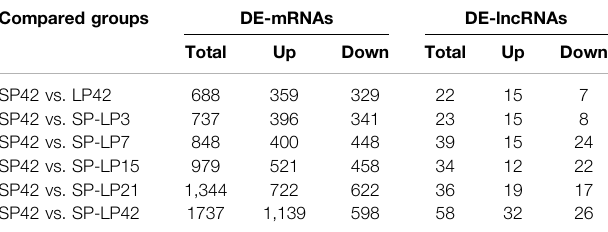
TABLE 3 | Summary of differentially expressed lncRNAs and